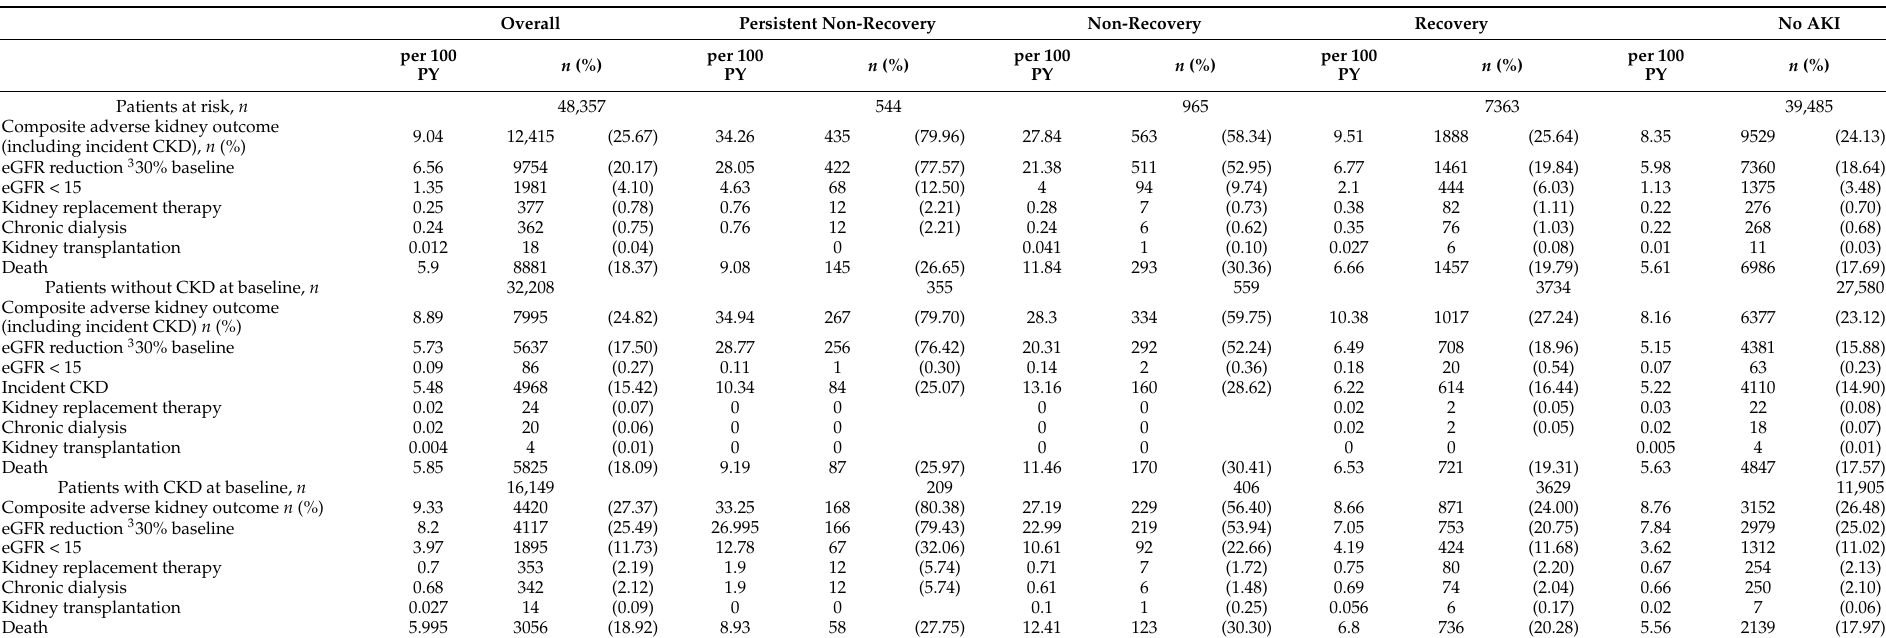
Table 2. Adverse kidney outcomes among patients at risk 6 months after index hospital discharge ( n =